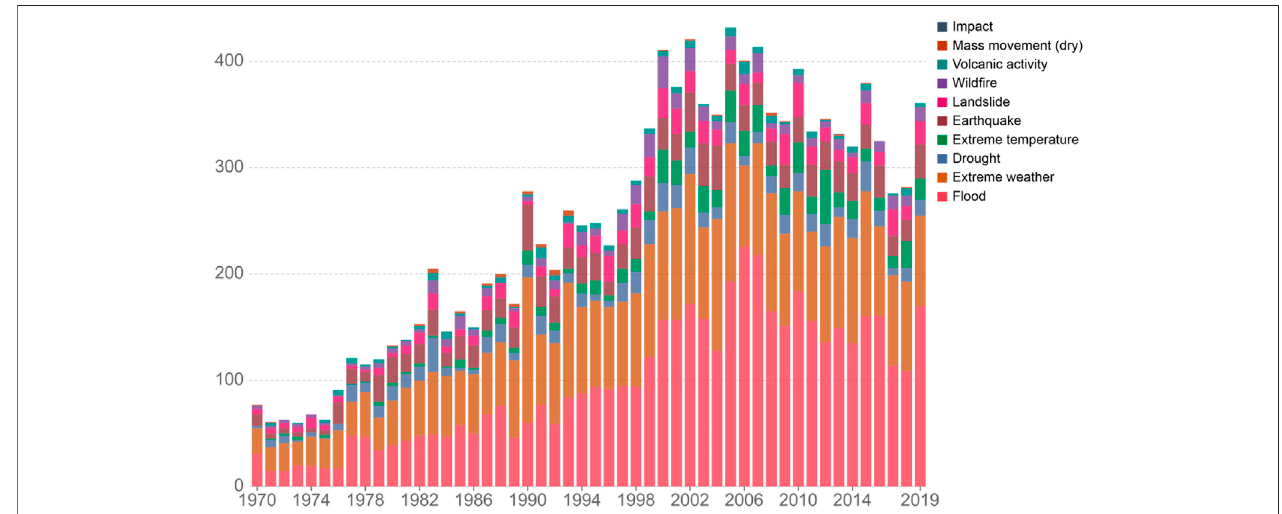
FIGURE 1 | Global reported natural disasters during 1970 – 2019 (EMDAT,